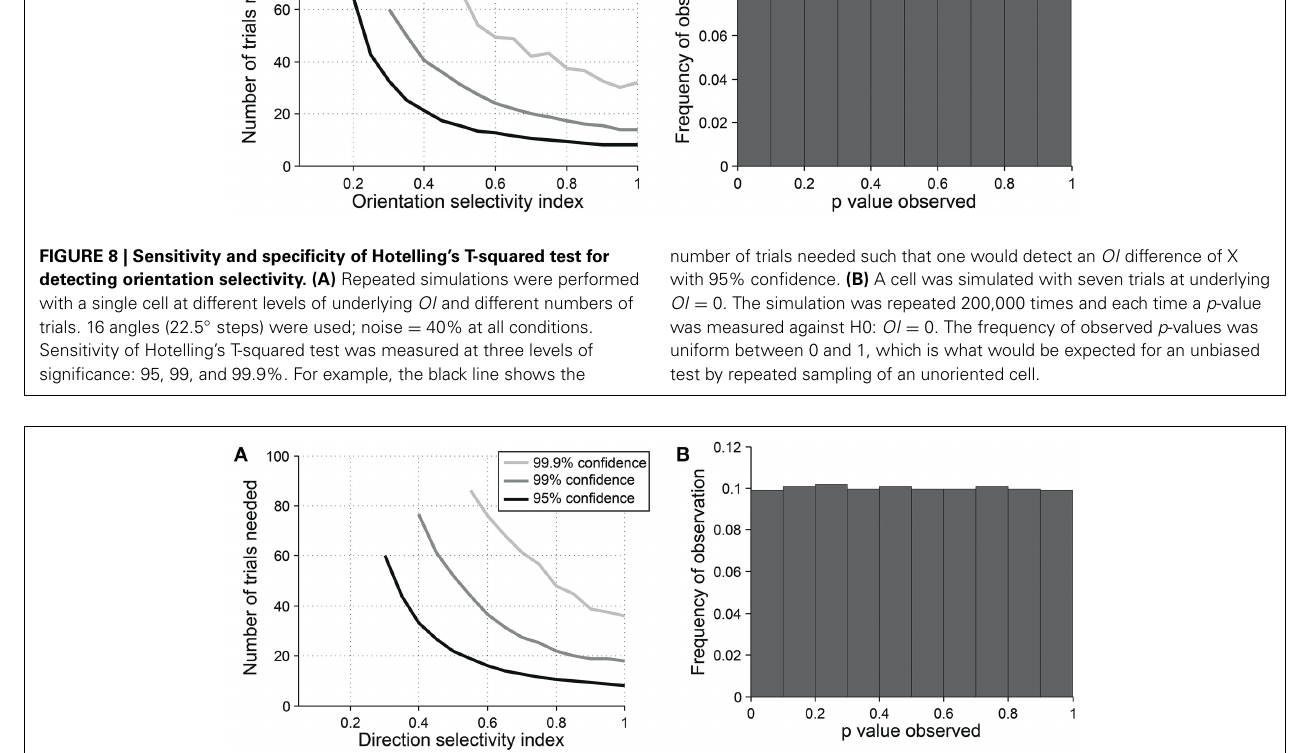
FIGURE 9 | Sensitivity and specificity of the direction dot product test for detecting direction selectivity. (A) Repeated simulations were performed with a single cell at different levels of underlying DI and different numbers of trials; OI = 1 for all simulations. 16 angles (22.5 ◦ steps) were used; noise = 4Hz at all conditions. Sensitivity of the direction dot product test was measured at three levels of significance: